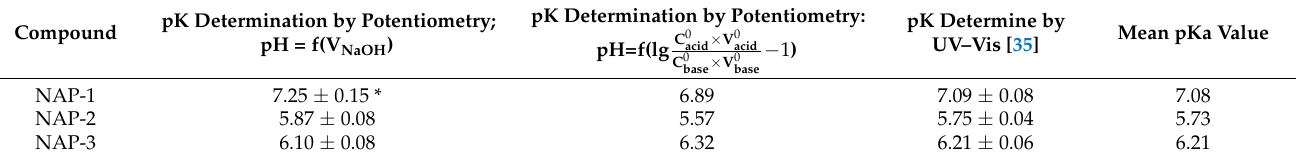
* Confidence intervals are calculated from at least three replicates of the determinations by each method.